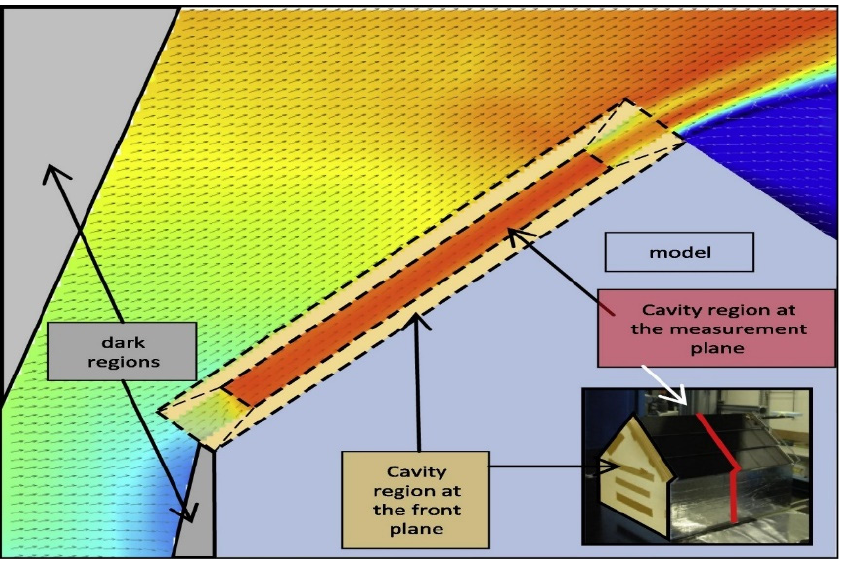
Figure 6. The proposed BIPV system with cavity ventilation air. Reproduced with permis- sion from ref. [158]. Copyright 2014 Elsevier. ref. [158]. Copyright 2014